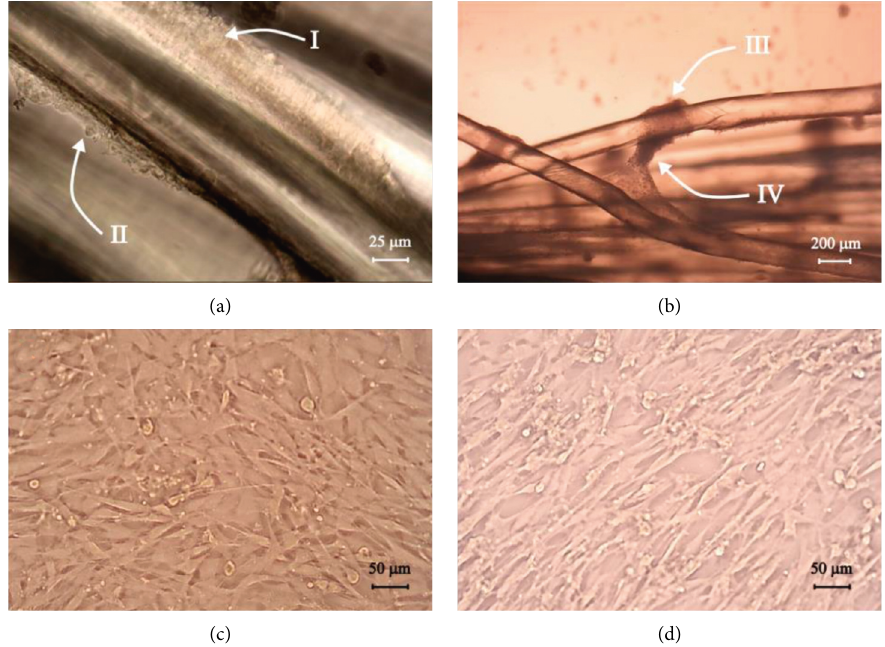
Figure 4: C2C12 growth at day 3 (a) and day 7 (b) on the microfilaments; the C2C12 control cells without scaffolds at days 3 (c) and 5